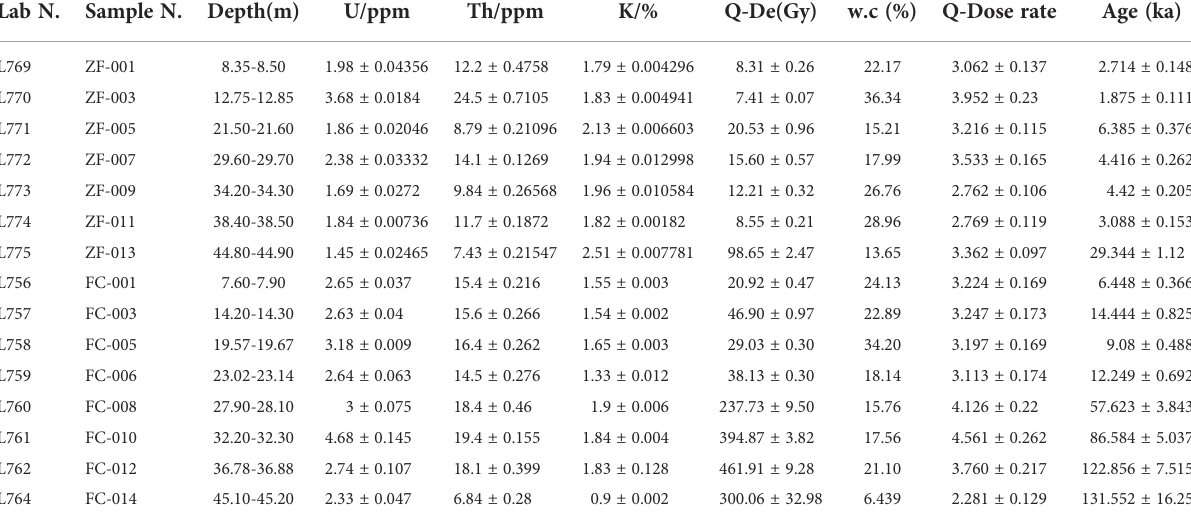
TABLE 1 The optical luminescence (OSL) dating results of the ZF and FC boreholes in Wuhu. Lab N. Sample N.